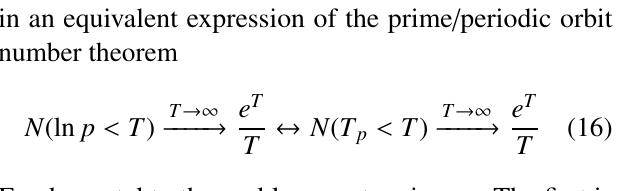
Figure 11: Correlation coe ffi cients of primes (a, c) and zeta zeros (b, d). While prime pairs have little correlation in their gap sizes, zeta zeros show consistent correlation, varying both as one moves up the zeros and as one examines longer range e ff ects. (a, b) Graph of correlation coe ffi cients using the first 20000 primes and zeros correlating di ff erences of adjacent values with those j units further on. (c, d) Colour map where ( i , j ) is the correlation coe ffi cient of the 500 pairs ( X , Y ) where X ( k ) = ( v ( k ) , v ( k + 1)) and Y ( k ) = ( v ( k + j ) , v ( k + j + 1)) , k = i , . . . , i + 500 . (e, f) Distributions of the first 600 primes (e) and zeta zeros